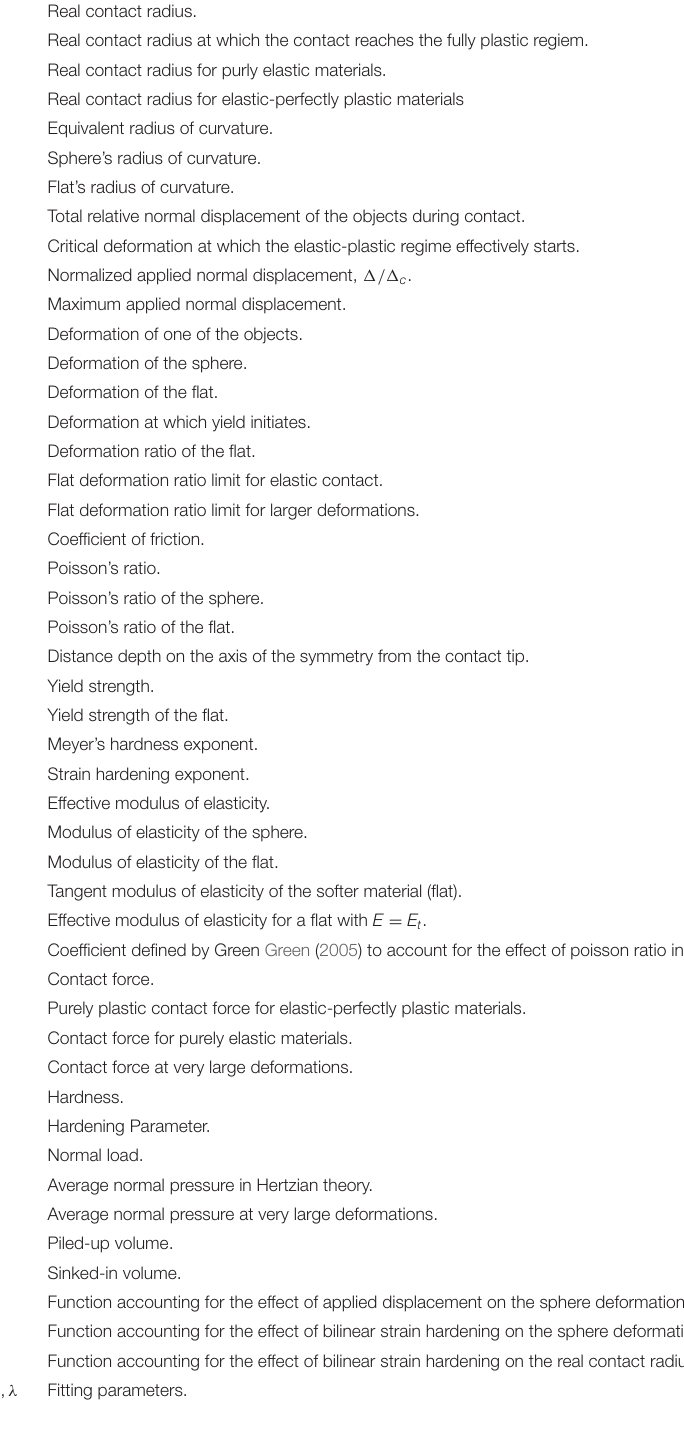
a Real contact radius. a p Real contact radius at which the contact reaches the fully plastic regiem. a e Real contact radius for purly elastic materials. a ep Real contact radius for elastic-perfectly plastic materials R Equivalent radius of curvature. R s Sphere’s radius of curvature. R f Flat’s radius of curvature. 1 Total relative normal displacement of the objects during contact. 1 c Critical deformation at which the elastic-plastic regime effectively starts. 1 n Normalized applied normal displacement, 1/1 c . 1 m Maximum applied normal displacement. δ Deformation of one of the objects. Deformation of the sphere. Deformation of the flat. δ y Deformation at which yield initiates. δ ∗ f Deformation ratio of the flat. δ ∗ fe Flat deformation ratio limit for elastic contact. δ ∗ fp Flat deformation ratio limit for larger deformations. Coefficient of friction. Poisson’s ratio. ν s Poisson’s ratio of the sphere. ν f Poisson’s ratio of the flat. z Distance depth on the axis of the symmetry from the contact tip. S y Yield strength. S yf Yield strength of the flat. n Meyer’s hardness exponent. n ǫ Strain hardening exponent. E Effective modulus of elasticity. E s Modulus of elasticity of the sphere. E f Modulus of elasticity of the flat. E t Tangent modulus of elasticity of the softer material (flat). E ∗ t Effective modulus of elasticity for a flat with E E t . = C Coefficient defined by Green Green (2005) to account for the effect of poisson ratio in the initation of yield. F Contact force. F p Purely plastic contact force for elastic-perfectly plastic materials. F e Contact force for purely elastic materials. F LD Contact force at very large deformations. Hardness. HP Hardening Parameter. N Normal load. P H Average normal pressure in Hertzian theory. P LD Average normal pressure at very large deformations. V p Piled-up volume. V s Sinked-in volume. φ Function accounting for the effect of applied displacement on the sphere deformation ratio. ψ Function accounting for the effect of bilinear strain hardening on the sphere deformation ratio. χ Function accounting for the effect of bilinear strain hardening on the real contact radius. α , β , λ Fitting